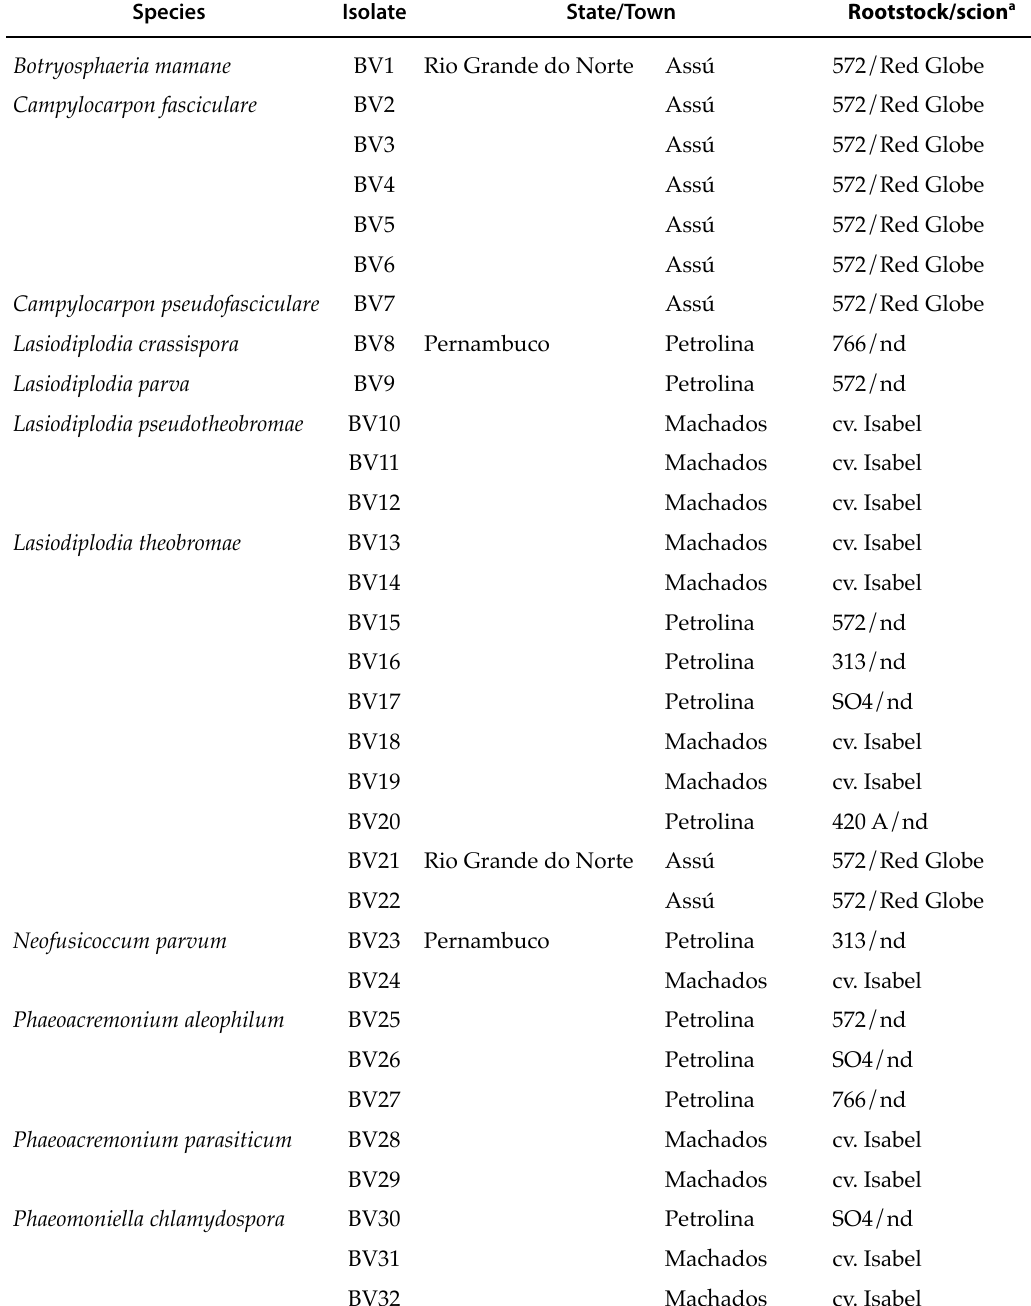
Table 1. List of fungal trunk pathogens isolated from table grapes in Northeastern Brazil, with their geographical origin.